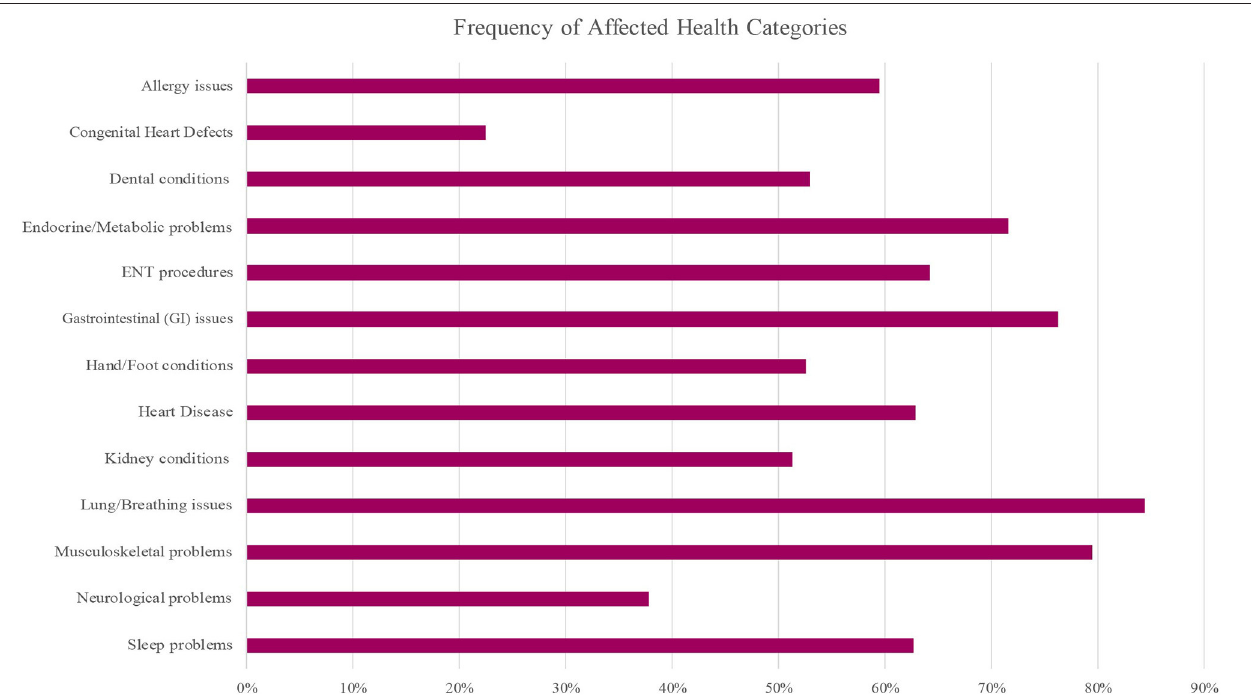
FIGURE 2 | Frequency of health issue categories affected in the WAGR Discovery Cohort. A variety of health categories were frequently affected. Approximately 75% or more of participants were affected by at least one issue in the Gastrointestinal (GI), Respiratory (lung/breathing), and Musculoskeletal categories. More than half of participants were affected by at least one issue in the Allergy, Dental, Endocrine/Metabolic, Heart Disease, Kidney conditions, Hand/Foot conditions and Sleep problems categories; ENT procedures were frequent. ENT, ear, nose, and throat; GI,